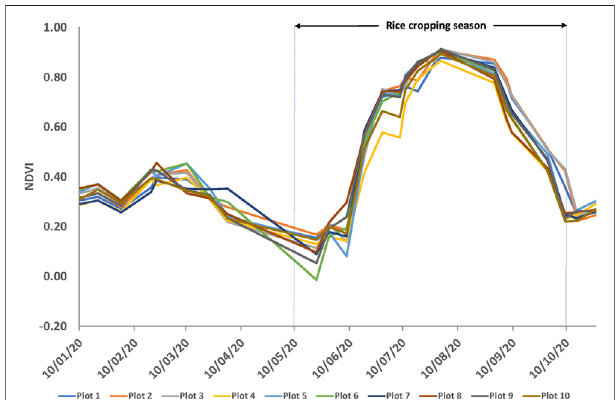
FIGURE2| NDVIaveragevaluescalculatedfortheselectedirrigatedrice fi eld plots (Quinta do Canal, Figure 1 ) using satellite Sentinel-2A imagery available for 2020, at 10 m spatial resolution. The period plotted include the rice cropping season, which lasted 151 days in 2020: sowing date was May 10 and harvest date was October 10.